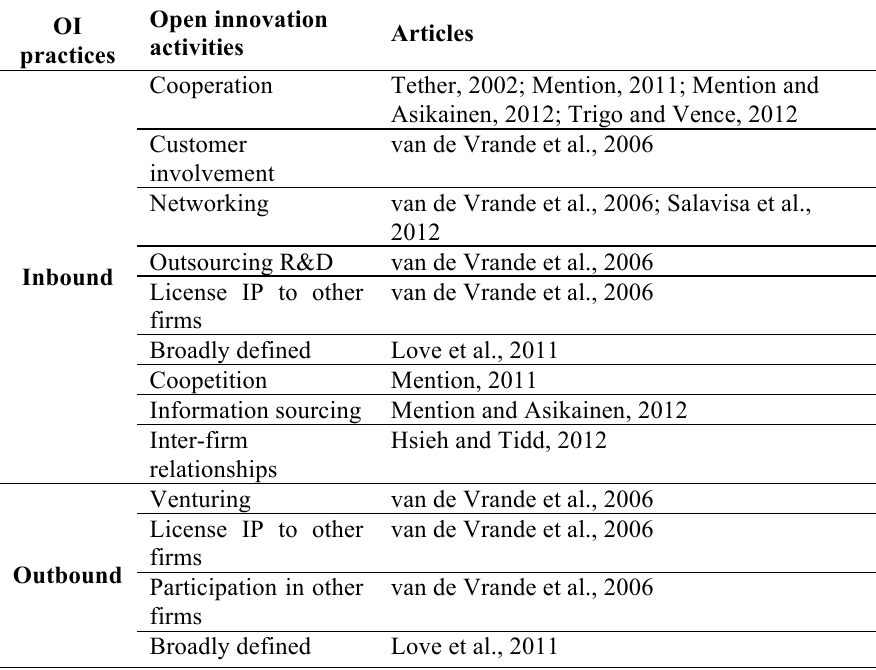
Table 1. OI practices and activities in the service industry-Literature